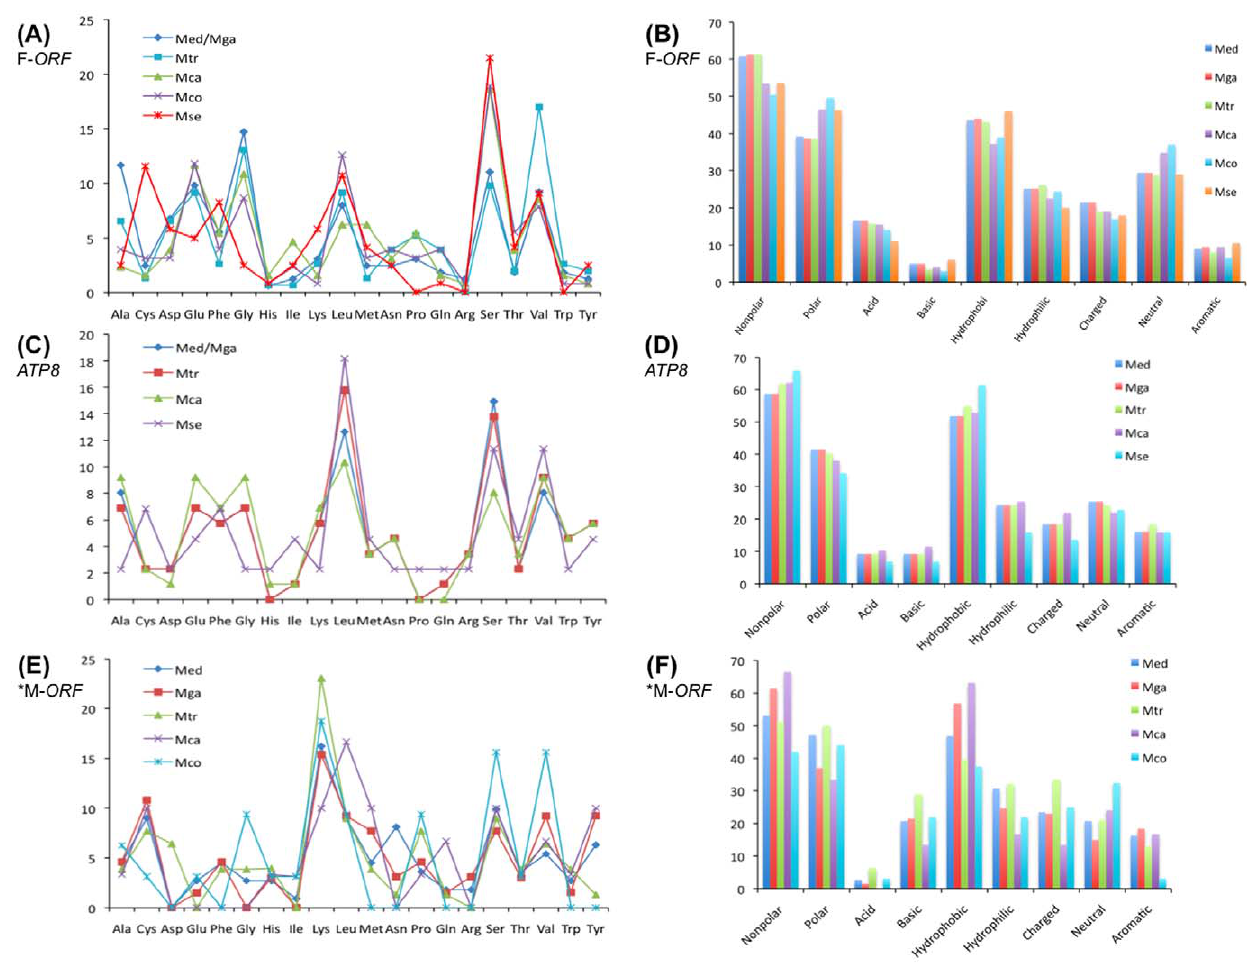
Figure 3. Amino acid composition of mytilid F-specific ORFs, protein-coding gene ATP8 and putative M- ORF-VD1 . (A) Overall amino acid composition of Mytilus spp. F- ORF-VD1 and M. senhousia F- ORF protein sequences. (B) Composition of chemically equivalent amino acids of Mytilus spp. F- ORF-VD1 and M. senhousia F- ORF protein sequences. (C) Overall amino acid composition of Mytilus spp. F- ATP8 and M. senhousia F- ATP8 protein sequences. (D) Composition of chemically equivalent amino acids of Mytilus spp. F- ATP8 and M. senhousia F- ATP8 protein sequences ( M. coruscus atp8 sequence is not available in GenBank). (E) Overall amino acid composition of the putative Mytilus spp. M- ORF-VD1 (*mean values for several M- ORF-VD1 GenBank sequences for each species). (F) Composition of chemically equivalent amino acids of the putative Mytilus spp. M- ORF- VD1 (such ORF has not been found in M. senhousia ). Amino acid composition is reported as percentage. Mca, M. californianus ; Mco, M. coruscus ; Med, M. edulis ; Mga, M. galloprovincialis ; Mse, M. senhousia ; Mtr, M. trossulus